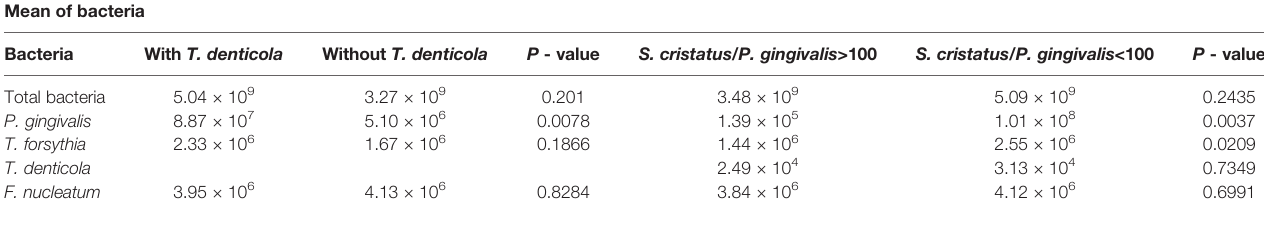
TABLE 4 | Impact of T. denticola and the S. cristatus/P. gingivalis ratios on the abundance of periodontitis-associated species. Mean of bacteria